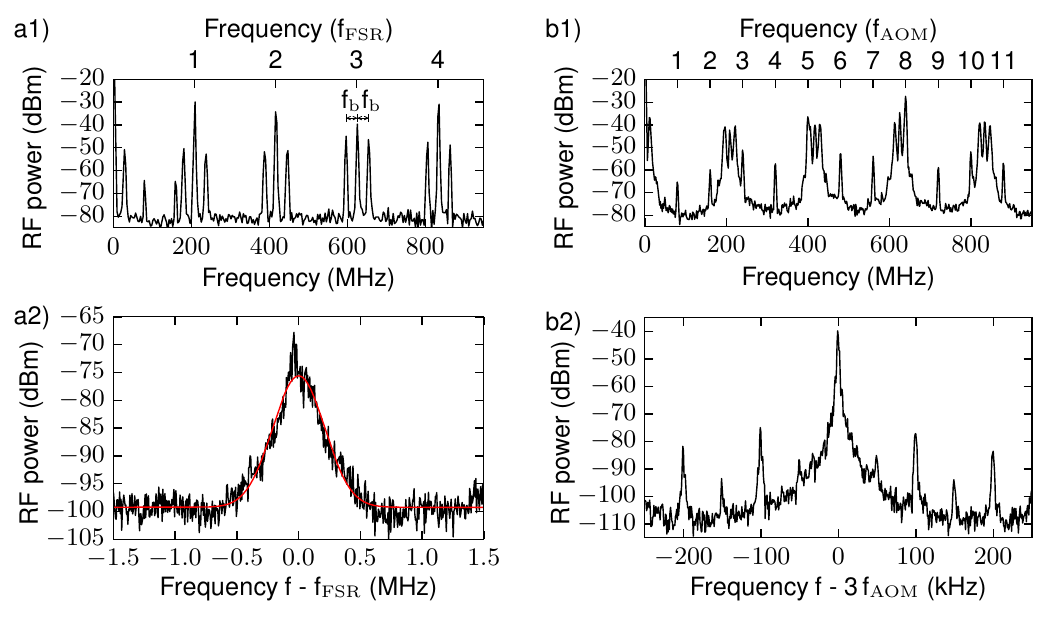
Figure 3: RF noise spectrum of the Michelson interferometer output. (a) Output of the mod- eless broadband laser. (a2) Zoom on the peak at f and Gaussian fit. The width of the FSR Gaussian is 430(7) kHz. (b) Output of the FSF laser seeded with 450 µ W cw narrow-band light. (b2) Zoom on the peak at 3 f . The half-width at half-maximum is (30 ± 2) AOM